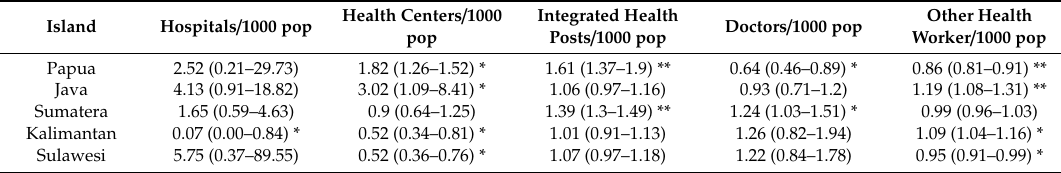
Table 2. Determinants of children’s DTP immunization status by island (Model 2).